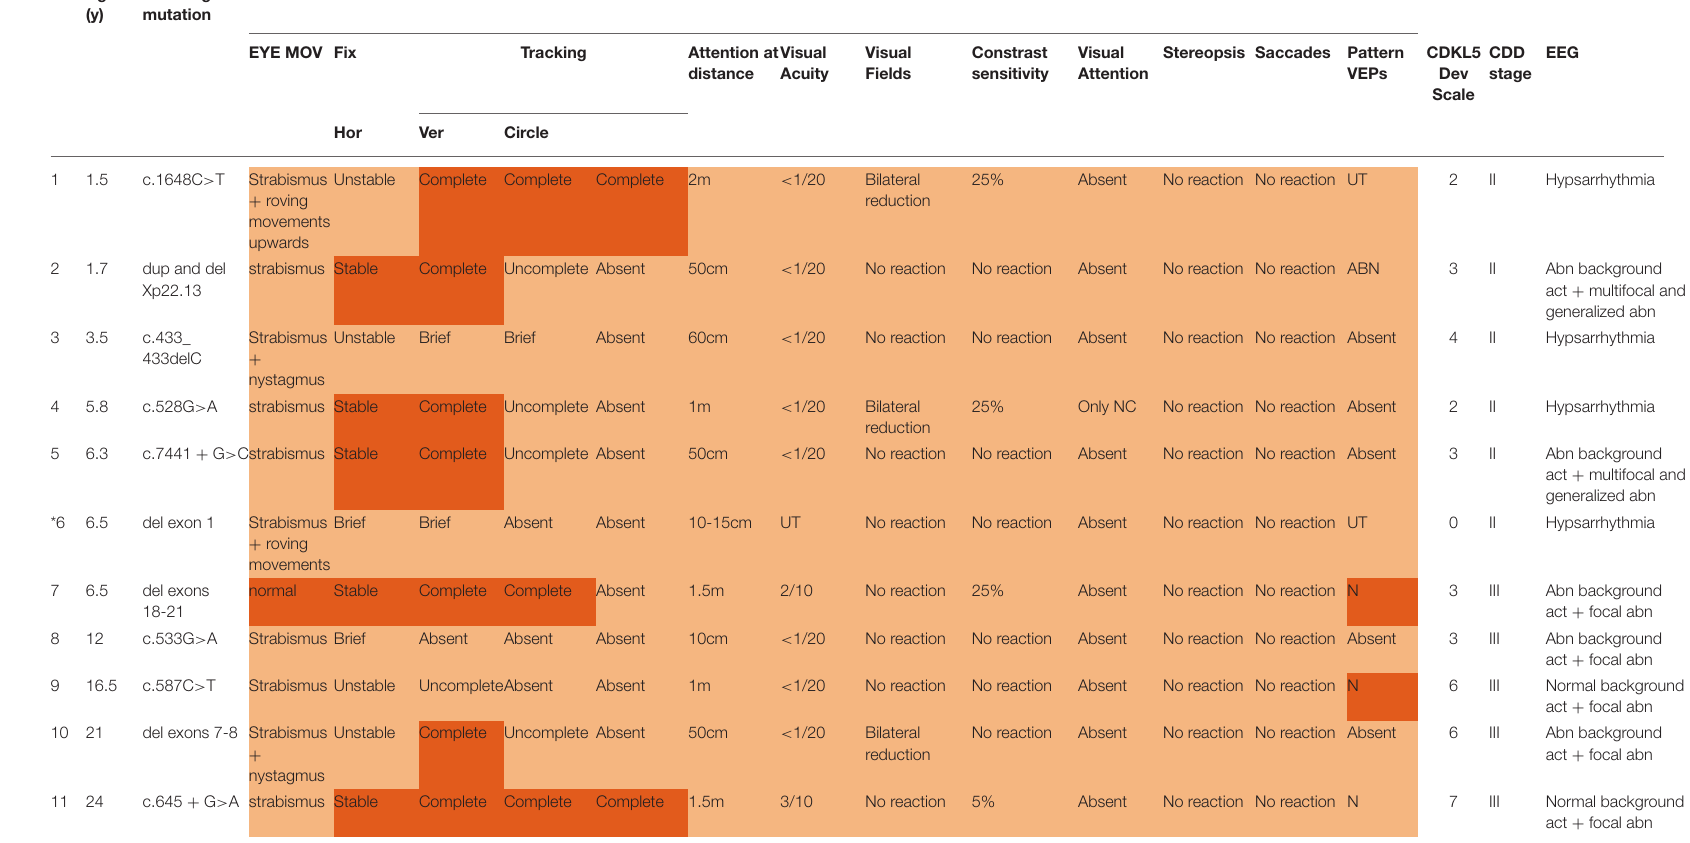
TABLE 1 | Detailed results for each